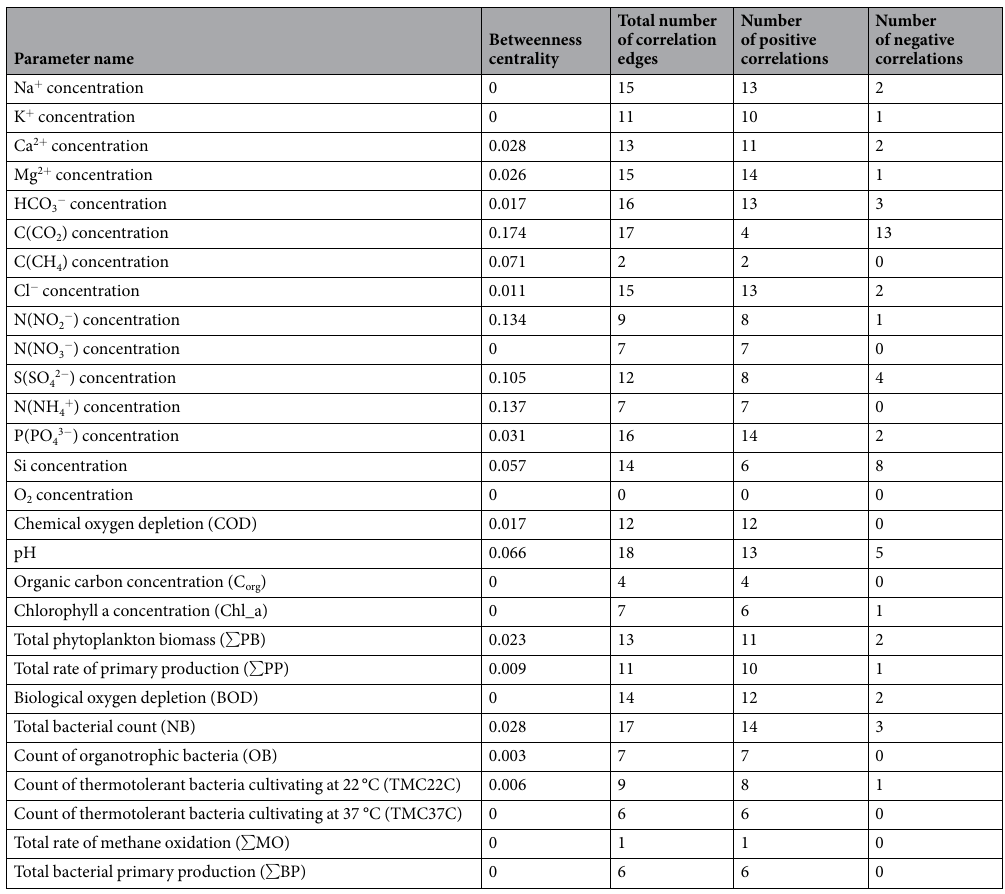
Table 3. Numeric parameters of biological and hydrochemical variables as the nodes in correlation network built for water